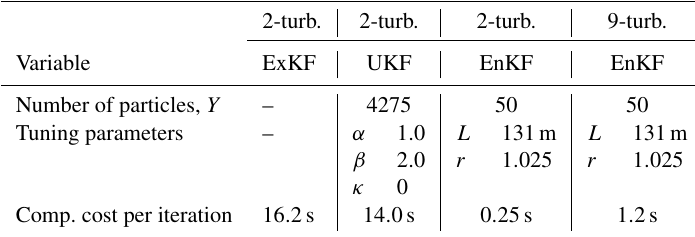
Table 4. Overview of several settings for the SOWFA and the WFSim nine-turbine wind farm simulation. Variable Symbol SOWFA Domain